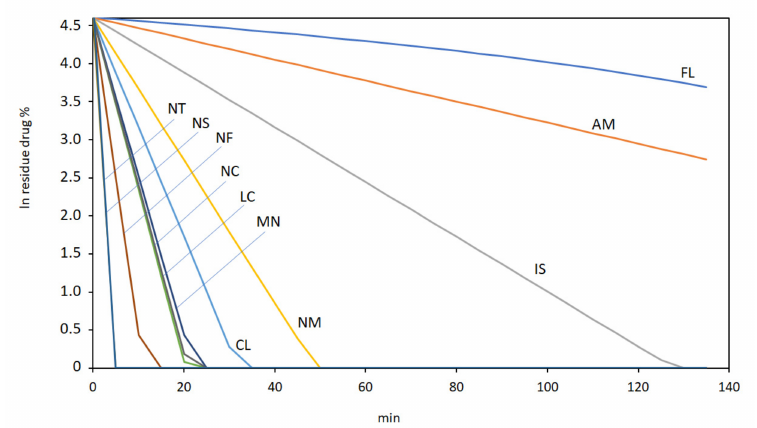
Figure 2. Kinetic curves resulting from the degradation test on hydroalcoholic DHP solutions in quartz containers: amlodipine (AM), cilnidipine (CL), felodipine (FL), isradipine (IS), lacidipine (LC), manidipine (MN), nicardipine (NC), nifedipine (NF), nimodipine (NM), nisoldipine (NS), and nitrendipine (NT).